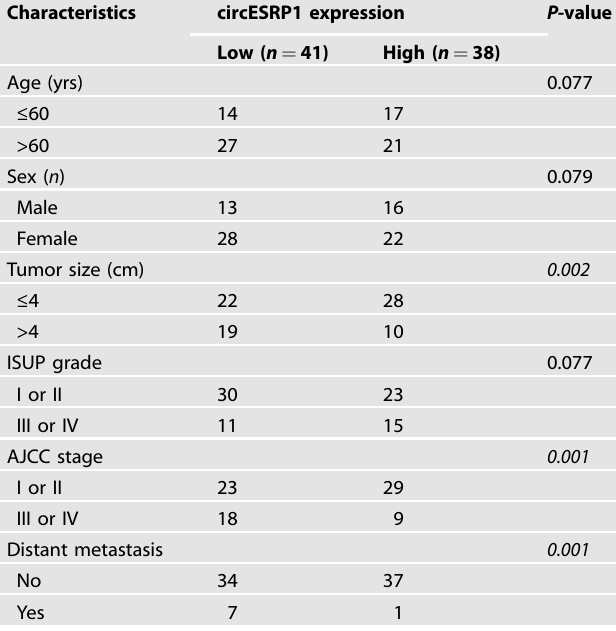
Table 1. Correlation within circESRP1 expression and the clinicopathological characteristic of ccRCC patients.